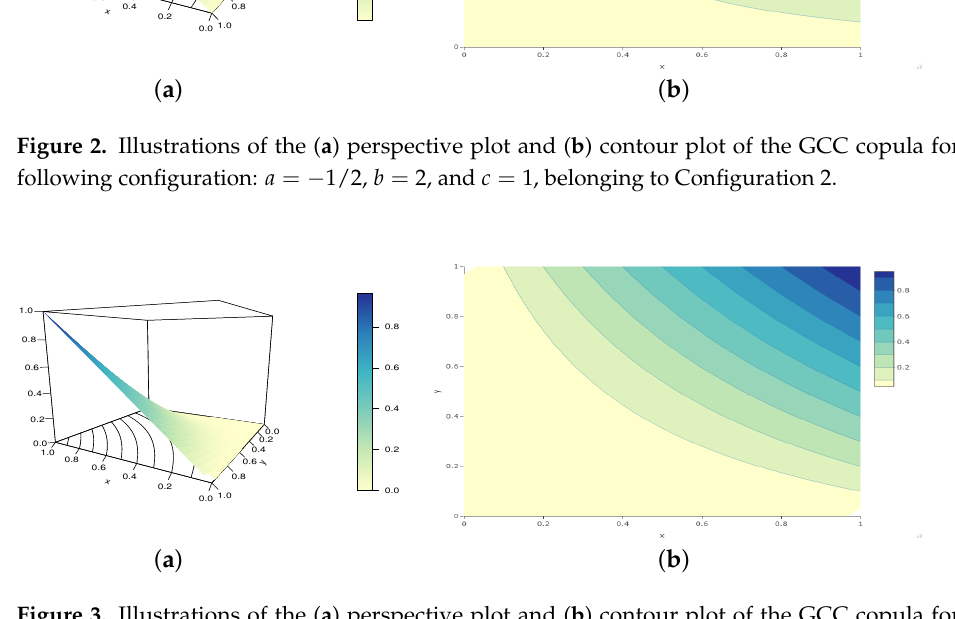
Figure 3. Illustrations of the ( a ) perspective plot and ( b ) contour plot of the GCC copula for the following configuration: a = − 2 and b = c = − 1/2, belonging to Configuration